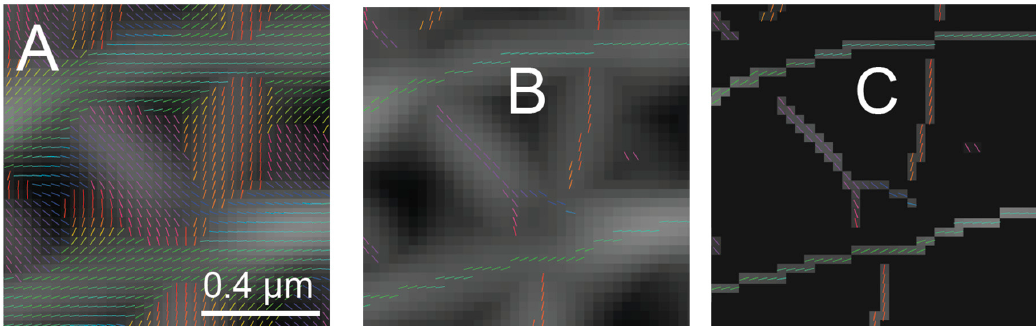
Figure 3. Orientation Detection and Non-Maximum Suppression of Steerable Filter Response of a SIM Image of a Lmnb1 -/- MEF. The orientation corresponding to the maximum response (argmax) of steerable filter bank ( A ) is overlaid on the maximum response value image as shown in Figure 2B. The orientation is indicated both by the slope of the lines drawn and their color according to an Hue-Saturation-Value (HSV) color map. Non-maximum suppression (NMS) is applied to the orientation indicators ( B ). The orientation indicators are only shown if the steerable filter response is larger than the interpolated values in either direction perpendicular to the orientation. The non-maximum suppression (NMS) is then applied to the maximum response ( C ) and orientation indicators (B). Response values are set to zero unless the steerable filter response is larger than the interpolated values in either direction perpendicular to the orientation. The white scale bar indicates 0.4 micrometers. The figure has been adapted from portions of Shimi and Kittisopikul et